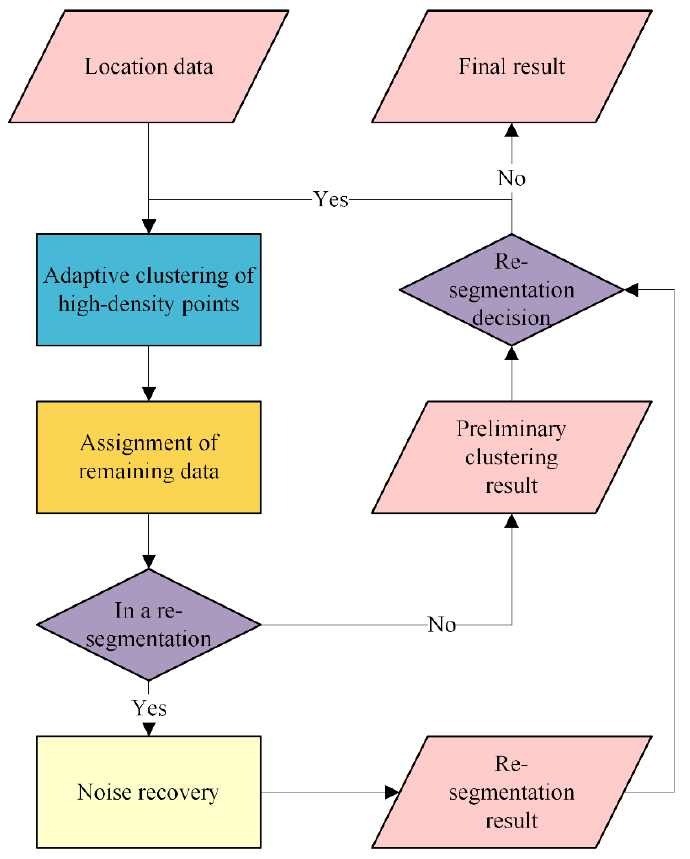
Figure 3. Workflow of ELV with four main processing steps. The parallelograms represent the raw data, processed data, and results. The rectangles refer to the three clustering steps and other steps are judgment mechanisms, shown by diamonds.